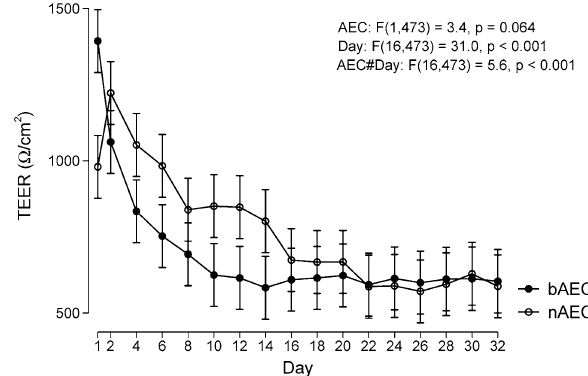
Figure 2. Barrier activity imparted by nAEC and bAEC epithelia aligns sixteen days after air-lift. Trans- epithelial electrical resistance (TEER) was assessed/compared in cultures of nAEC and bAEC as they differentiated into epithelia in the transwell system. Day 1 represents 24 h after the growth media was removed from the apical reservoir (“air-lift”). TEER was measured three times at each time point, every 48 h, for any one culture (n = 5 per participants per culture group) using each of the three ports in the transwell frame. TEER measures are expressed as resistance over the total membrane/cell coverage area (Ω cm 2 ). Results are presented as marginal means predicted from a multilevel linear mixed model with 95% confidence intervals. The time course is different between bAEC and nAEC (P < 0.001), individually significantly different between days 1–14 ( P < 0.05, Wald tests), and converging thereafter.